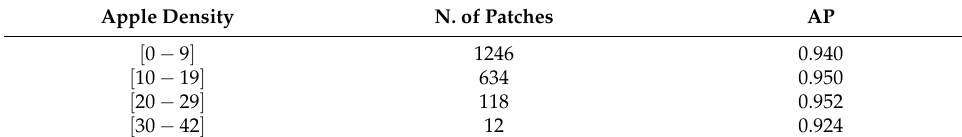
Table 6. Results of the ATSS in different apple densities in the patches.